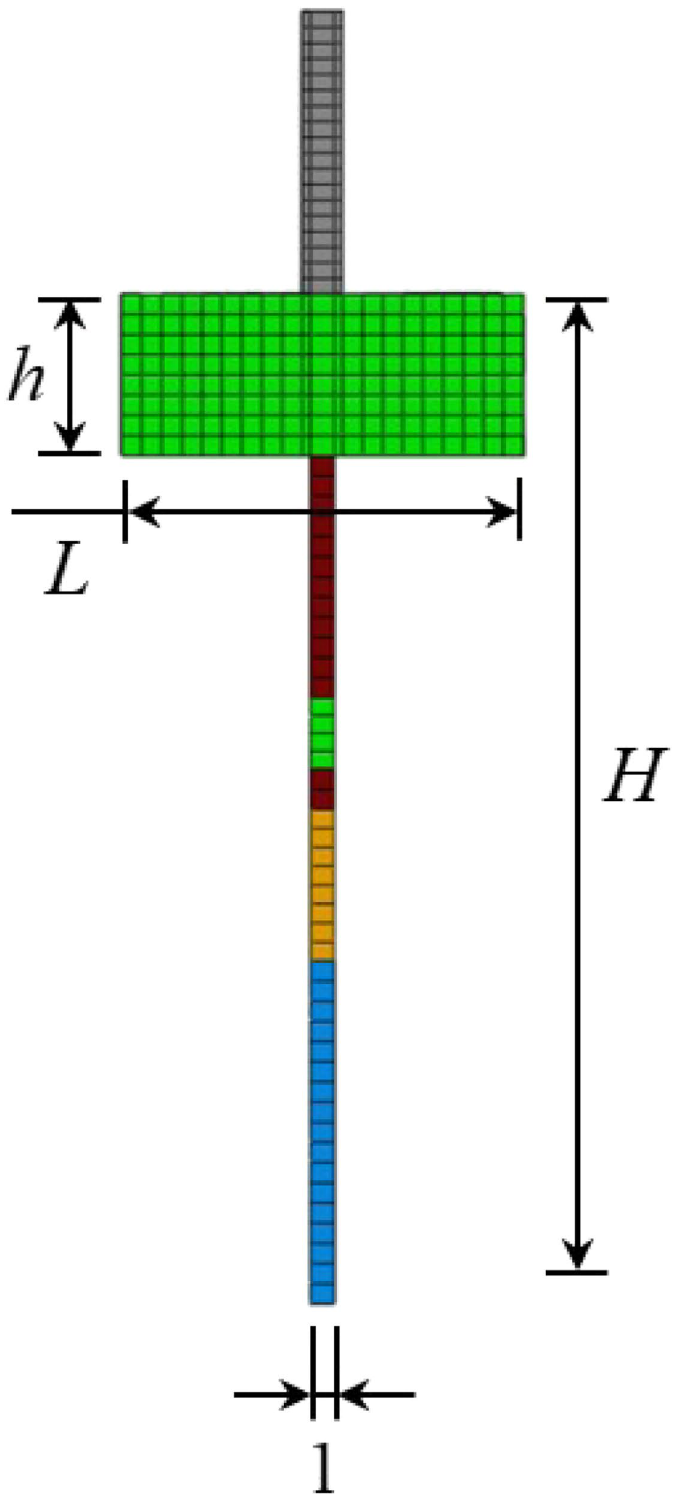
Fig. 2 Assembly of a pier and the T-shaped soil